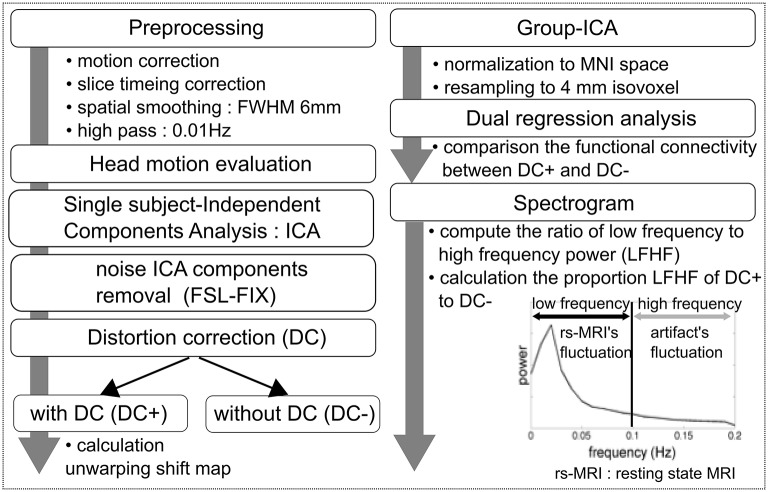
Workflow overview.